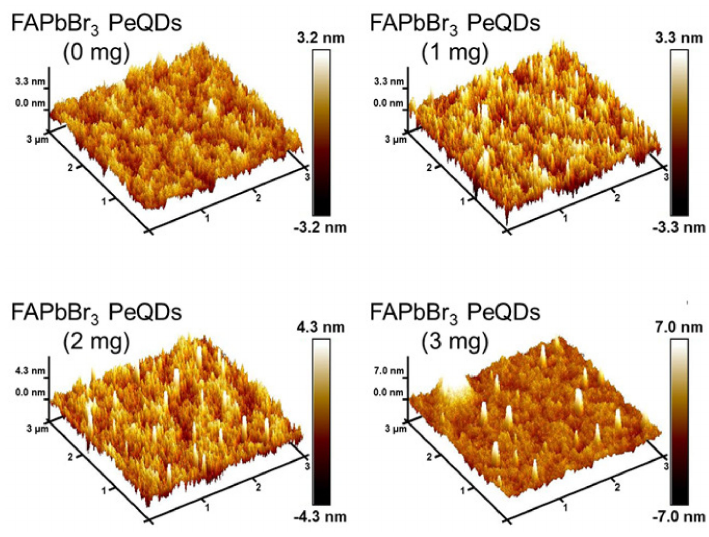
Figure 6. AFM images of the P3HT:PC 71 BM and P3HT:PC 71 BM:FAPbBr 3 PeQDs films. Table 2. The surface characterization parameters R a and R max of the corresponding samples.